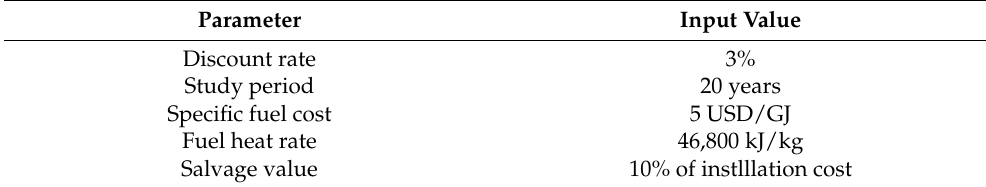
Table 5. Financial input parameters for the current